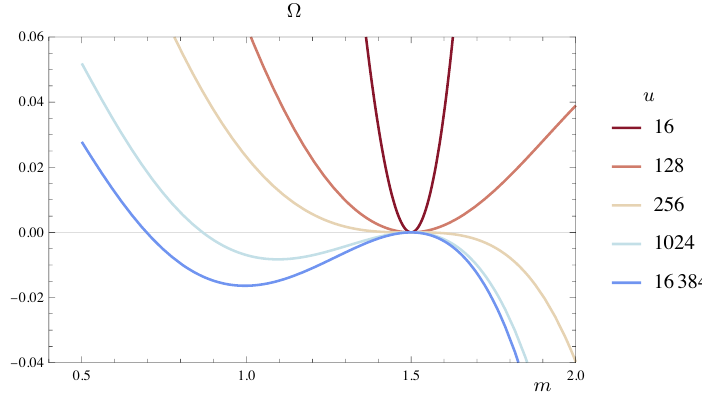
for r = 9 / (4 r 2 ) at different values of u . r 0 0